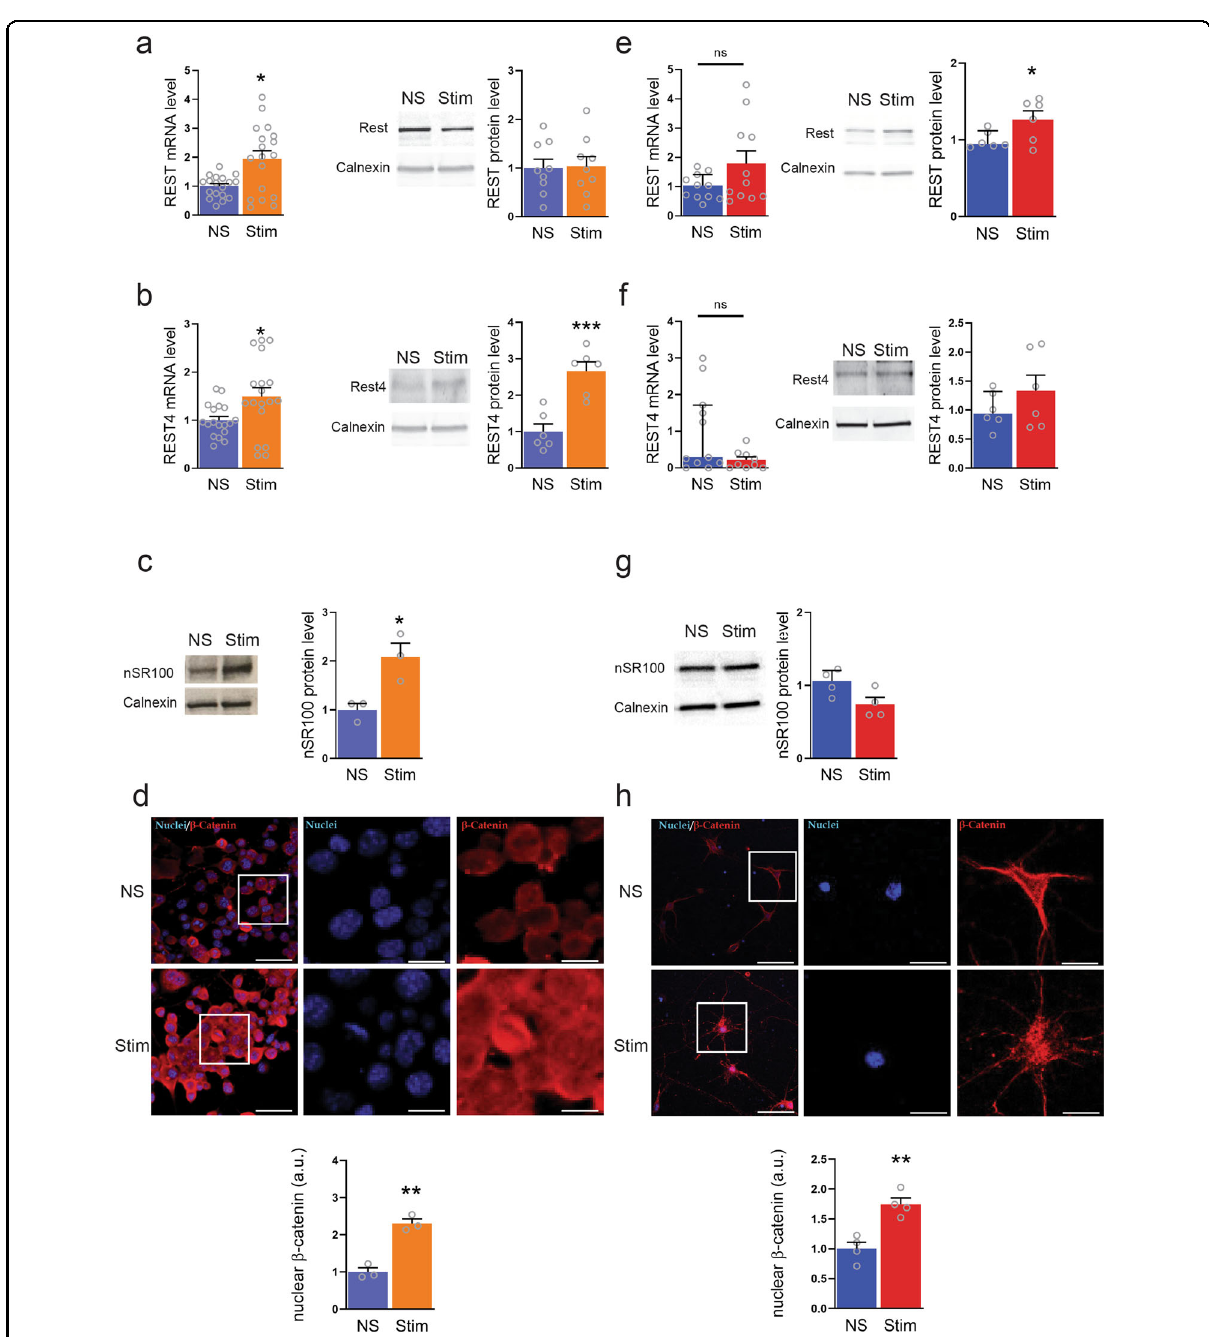
Fig. 1 Exposure to activated T cell supernatant differentially regulates alternative splicing of REST in N2a cells and primary cortical neurons. a – d Differentiated N2a cells were exposed to either activated (Stim) or non-activated (NS) T cell supernatant for 24h. a , b qRT-PCR (left) and western blotting analysis (right) were used to assess full-length REST ( a ) and REST4 ( b ) expression. c , d Analysis of nSR100 ( c ) and nuclear β -catenin ( d ) signals in Stim N2a cells compared to the control condition. e – h The same experimental procedures were carried out for primary cortical neurons. e , f qRT-PCR (left panels) and western blotting analysis (right panels) were used to assess REST ( e ) and REST4 ( f ) expression. g , h nSR100 ( g ) and nuclear β -catenin ( h ) signals in Stim neurons as compared to the control condition. Gapdh, Actin, and Hprt1 were used as housekeeping genes in qRT-PCR analyses. Calnexin was used as loading control for western blotting analyses. d , h Analysis of nuclear β -catenin signal. Representative images (top) and quanti fi cation (bottom) of nuclear β -catenin immunoreactivity (red) in N2a cells ( d ) and primary cortical neurons ( h ) treated with either control supernatant (NS) or activated T cell supernatant (Stim) for 24h. DAPI-stained nuclei are shown in blue. Separate channels are shown for the high-magni fi cation images of the boxed regions. Scale bars, 50 and 10 μ m for low and high magni fi cation, respectively. Bars show mean±sem of at least n = 3 independent experiments with individual data points. * p < 0.05, ** p <0.01, *** p <0.001, ns: p >0.05; Mann – Whitney U test/unpaired two-tailed Student ’ s t